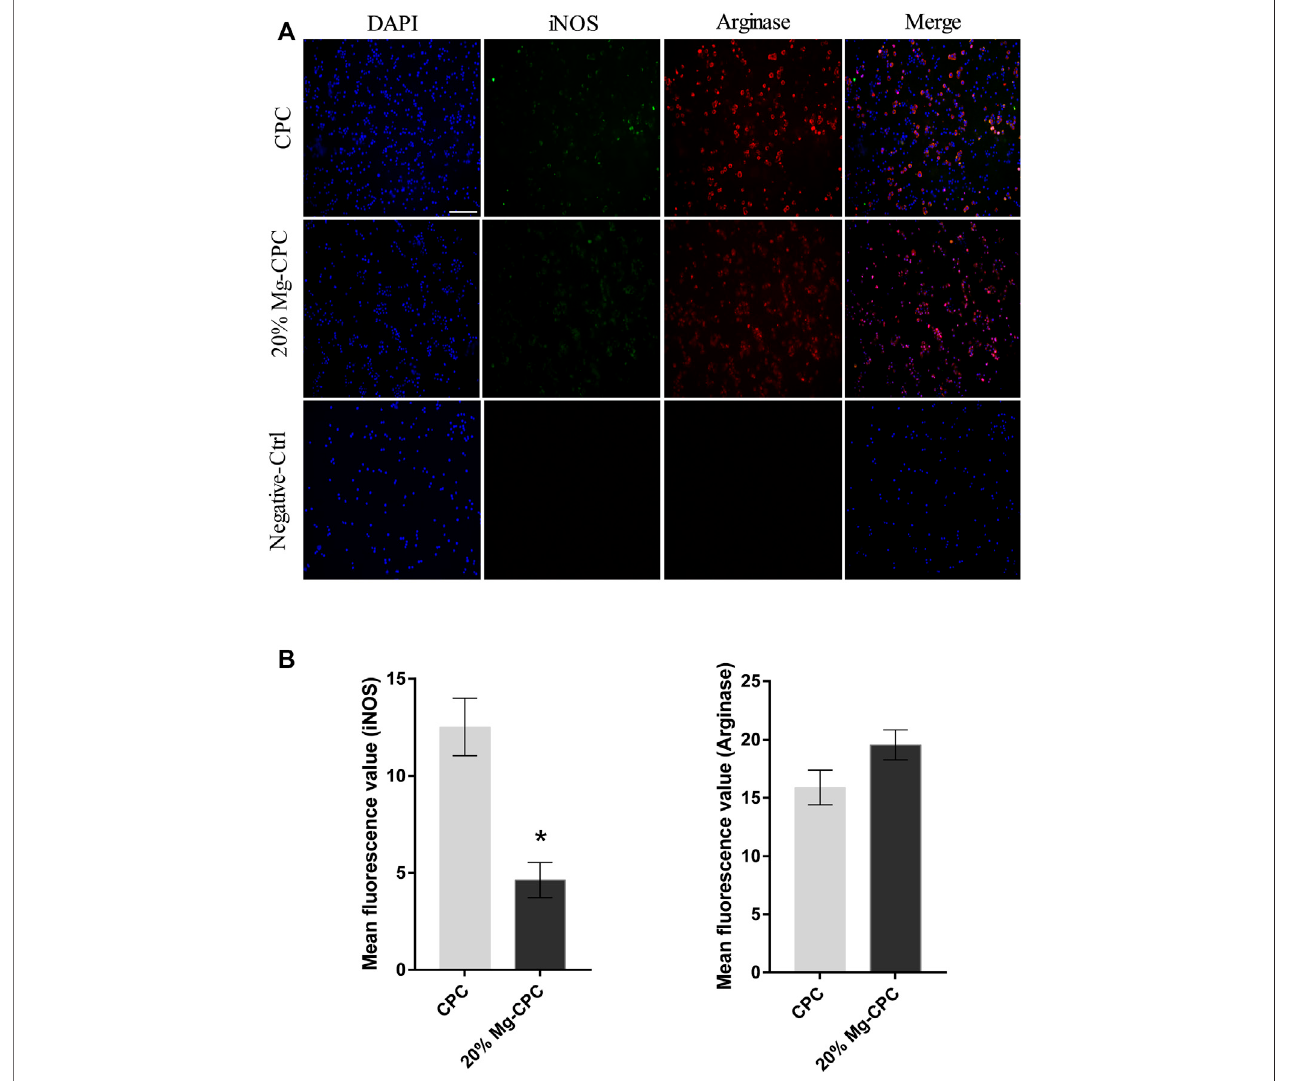
FIGURE 7 | Immuno fl uorescence staining of iNOS and Arginase in RAW 264.7. (A) Fluorescence images of RAW 264.7 cultured on cement for 24 h; blue dot: DAPI; green dot: iNOS; red dot: arginase (scale bar (cid:2) 200 μ m); (B) mean fl uorescence intensity calculation by software ImageJ (* p < 0.05).